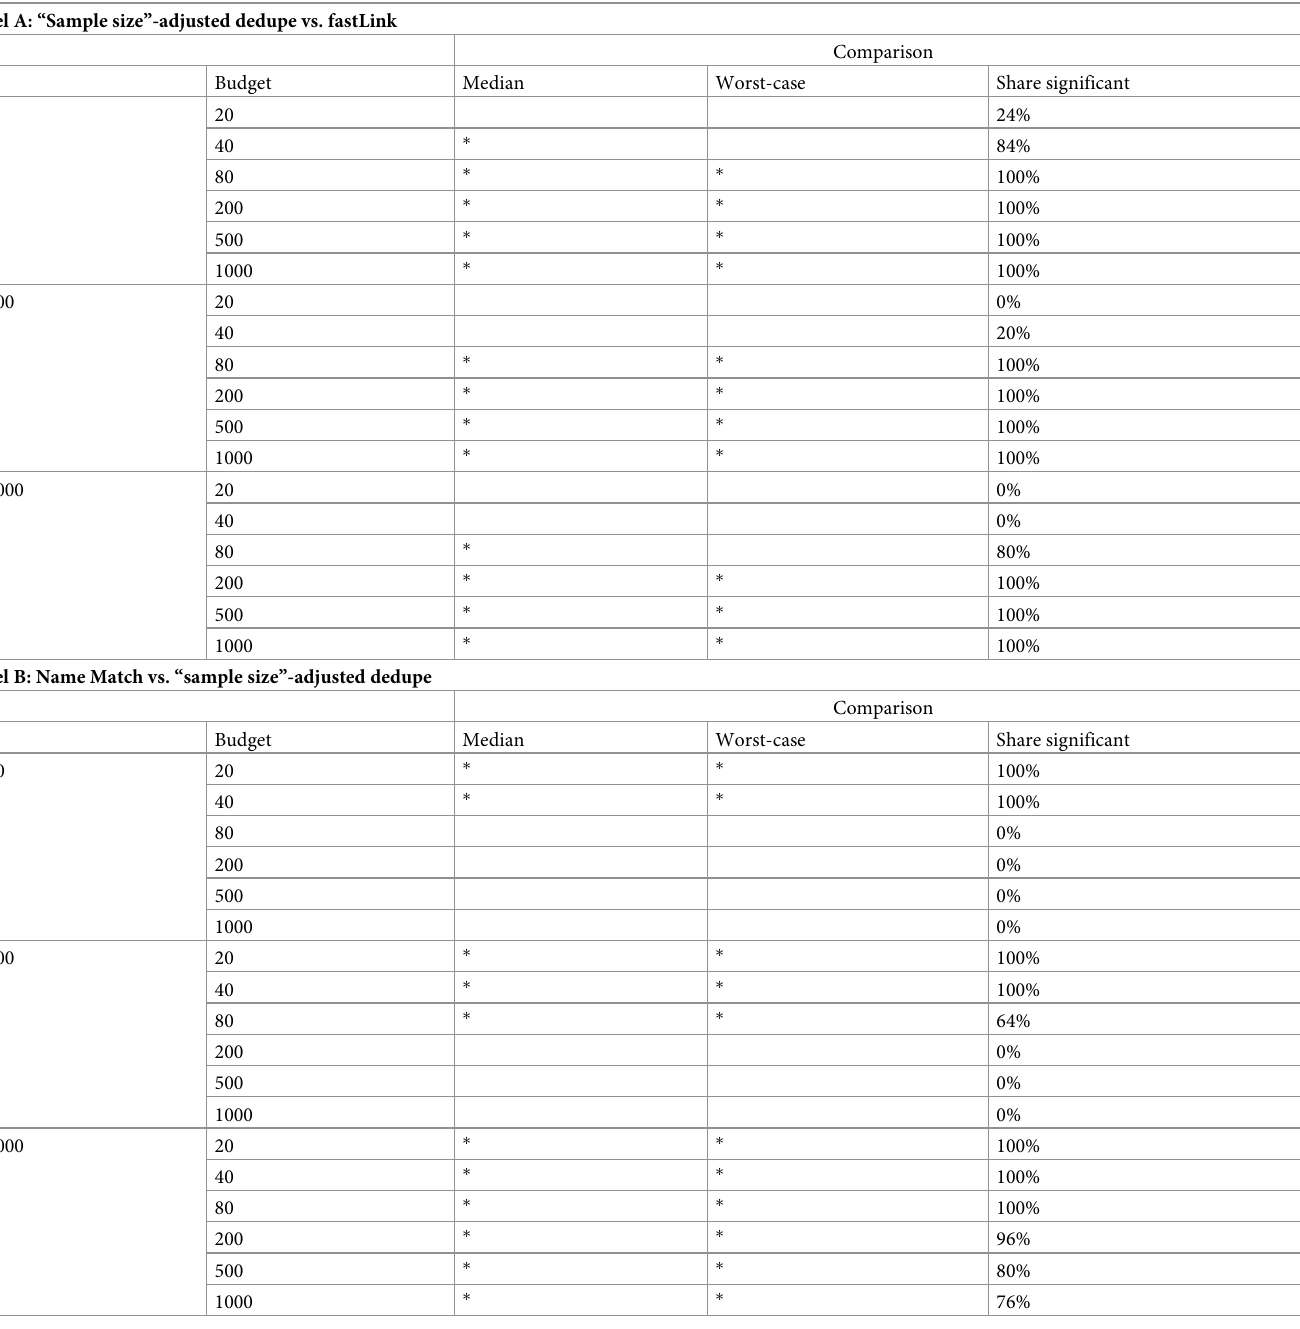
Table 3. Statistical comparisons of total error rate between “sample size”-adjusted dedupe with fastLink and Name Match. Panel A: “Sample size”-adjusted dedupe vs. fastLink